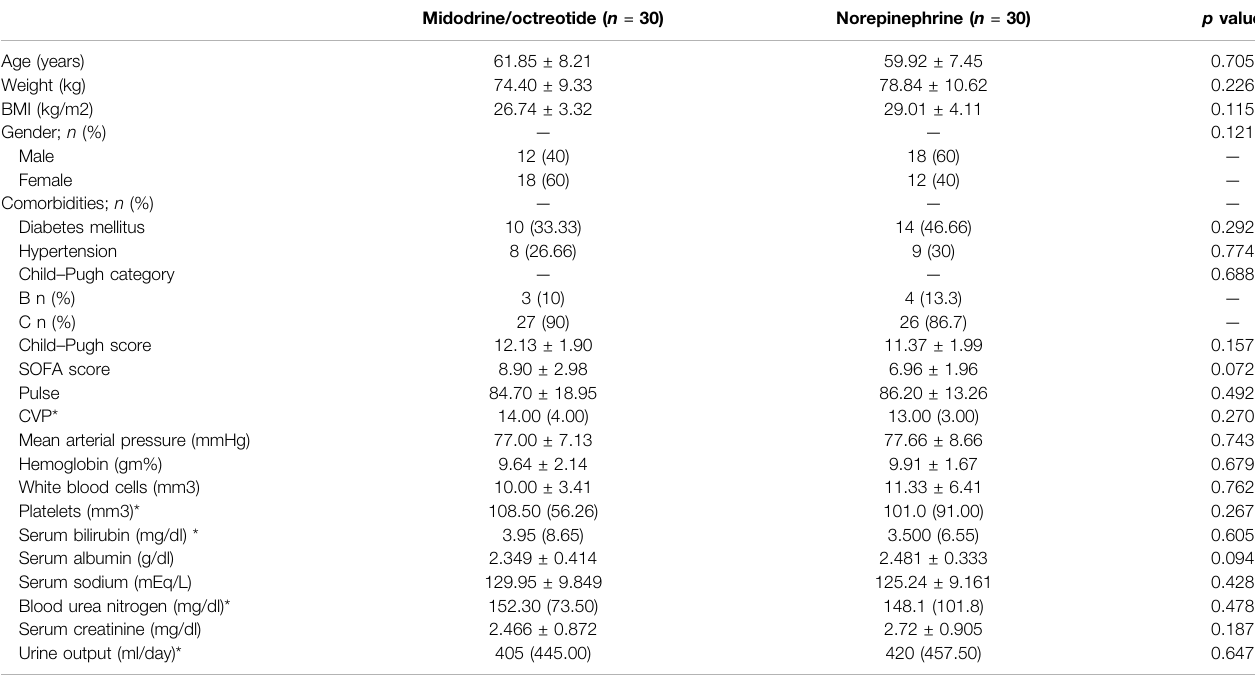
TABLE 1 | Baseline demographic, clinical, and biochemical variables of the study